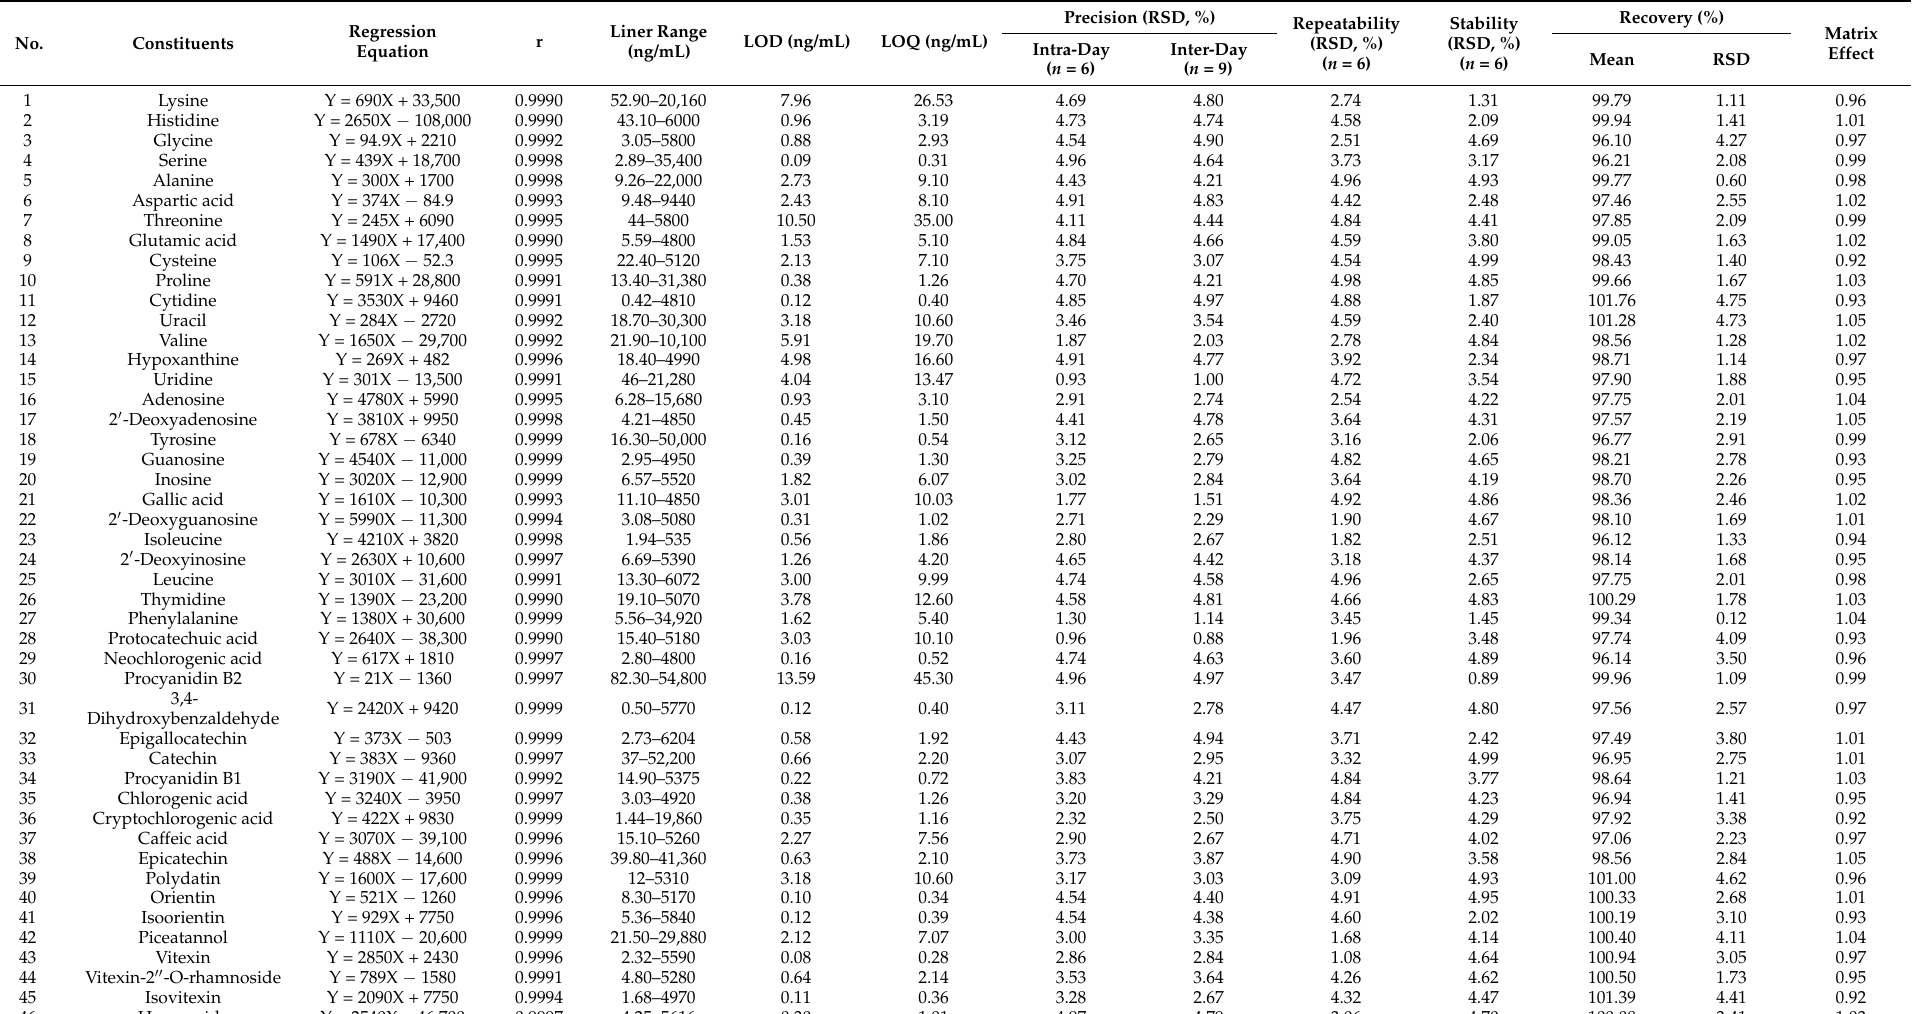
Table 2. Regression equations, limits of detection (LOD), limits of quantification (LOQ), precision, repeatability, stability, recovery, and matrix effect of 60